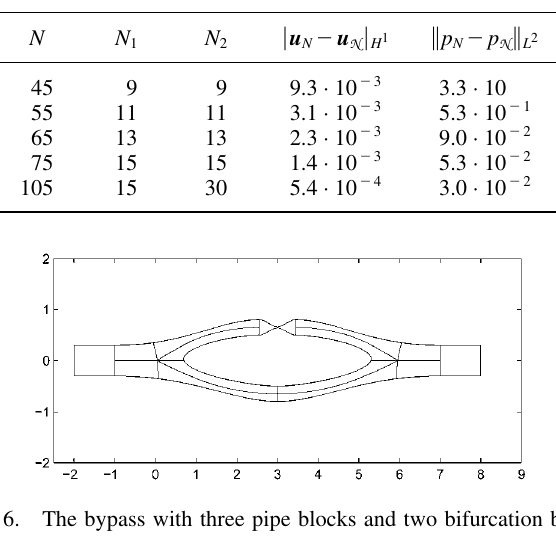
Table 4. The error in the reduced basis steady Stokes solution on a multiblock bypass with three pipe blocks and two